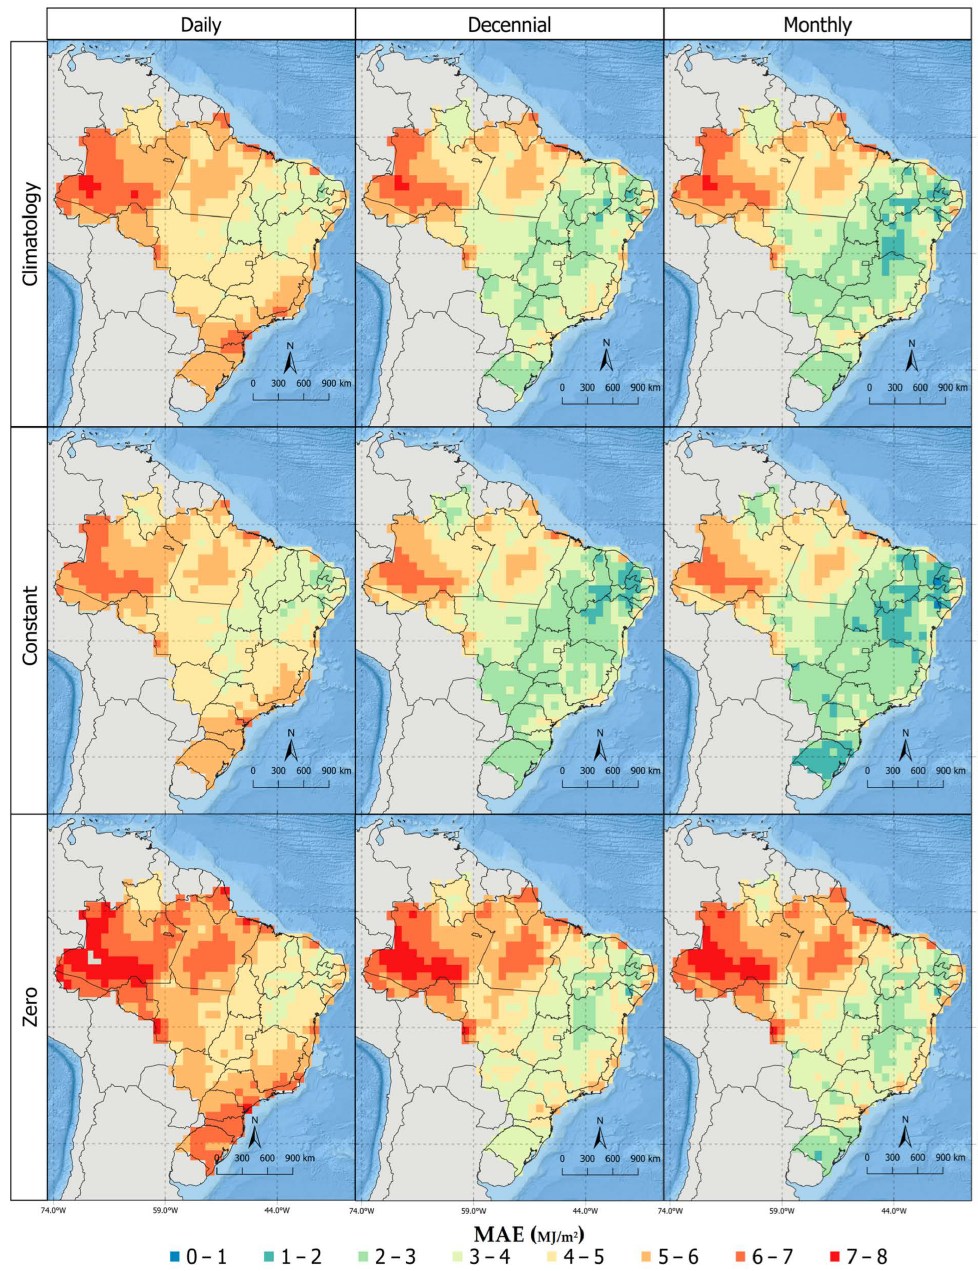
Figure 6. MAE of solar radiation (MJ/m 2 ). The upper panel is derived from the BAM-CLIM simulations, the middle panel is derived from the BAM-CTE simulations, and the bottom panel is derived from the BAM-ZERO simulations. The left column shows MAE on a daily scale, the middle column shows MAE on a decennial scale, and the right column shows MAE on a monthly